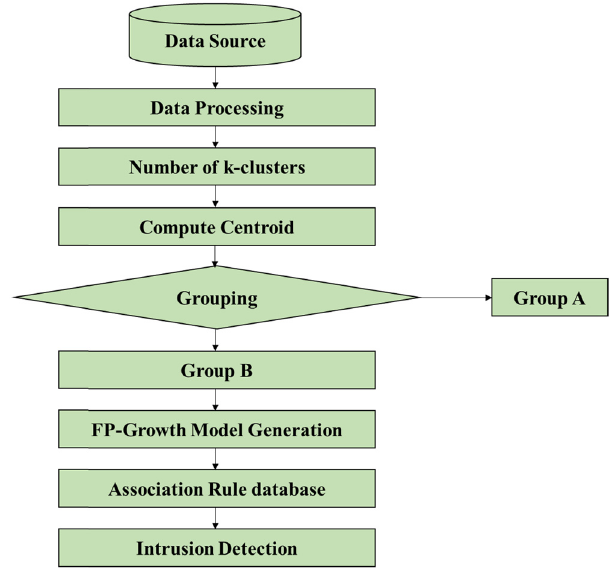
Figure 2: Flowchart of FP - growth